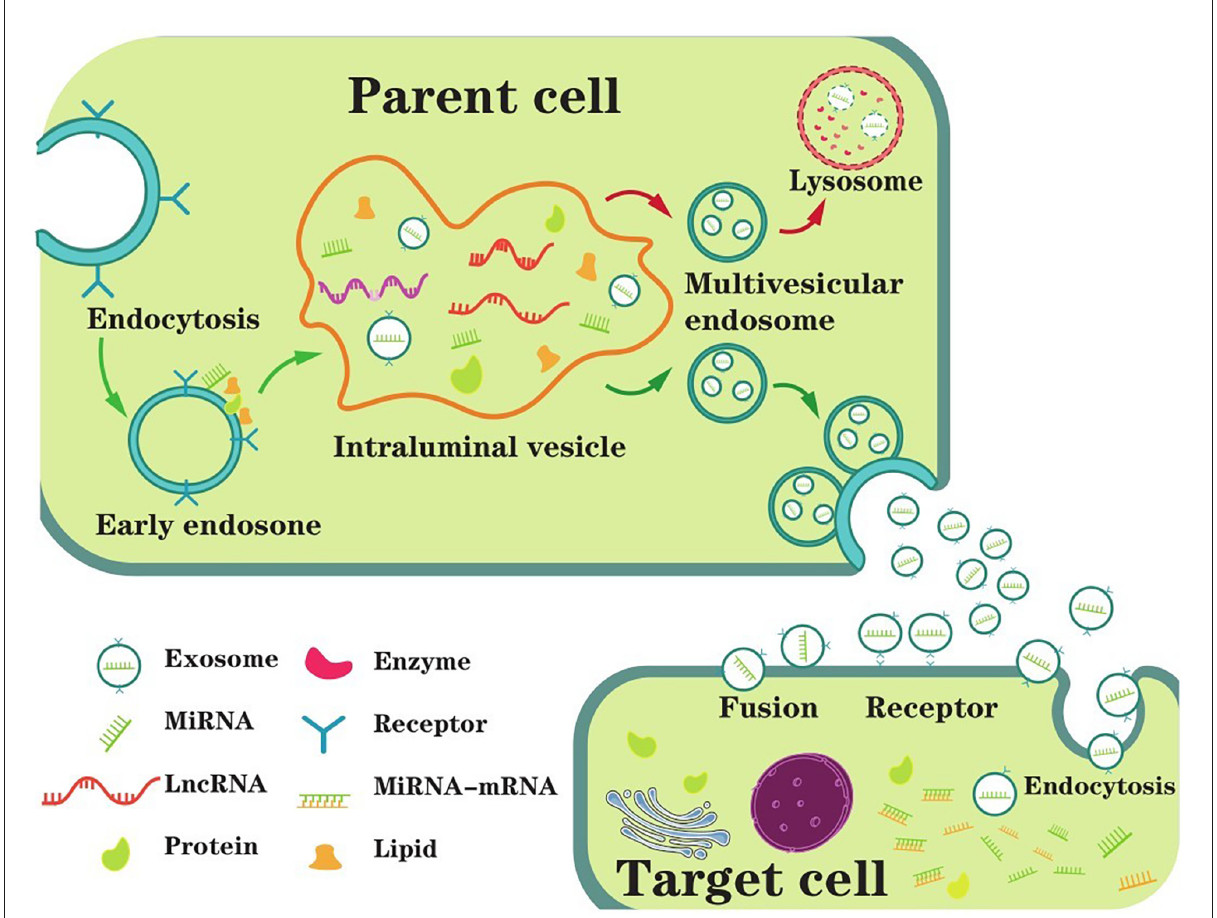
FIGURE1 The main process of exosome biogenesis, secretion, and ingestion. The biogenesis of exosomes starts with the formation of EEs (early endosomes) through endocytosis at the plasma membrane. Then, the EE begins inward budding starting from the membrane to form the endosome lumen, sequestering ncRNAs and other cytoplasmic molecules and eventually converting to intraluminal vesicles (ILVs). MVBs (multivesicular bodies) are matured from the segregation of the lumen from the plasma membrane leading to molecule accumulation in the ILVs, which are also called late endosomes. Generally, MVBs either fuse with the plasma membrane or fuse with the lysosome for degradation. In extracellular space, exosomes are untaken by target cells, mediating by endocytosis, fusion or receptor interaction. As a result, exosome contents are taken into recipient cells and exert biological